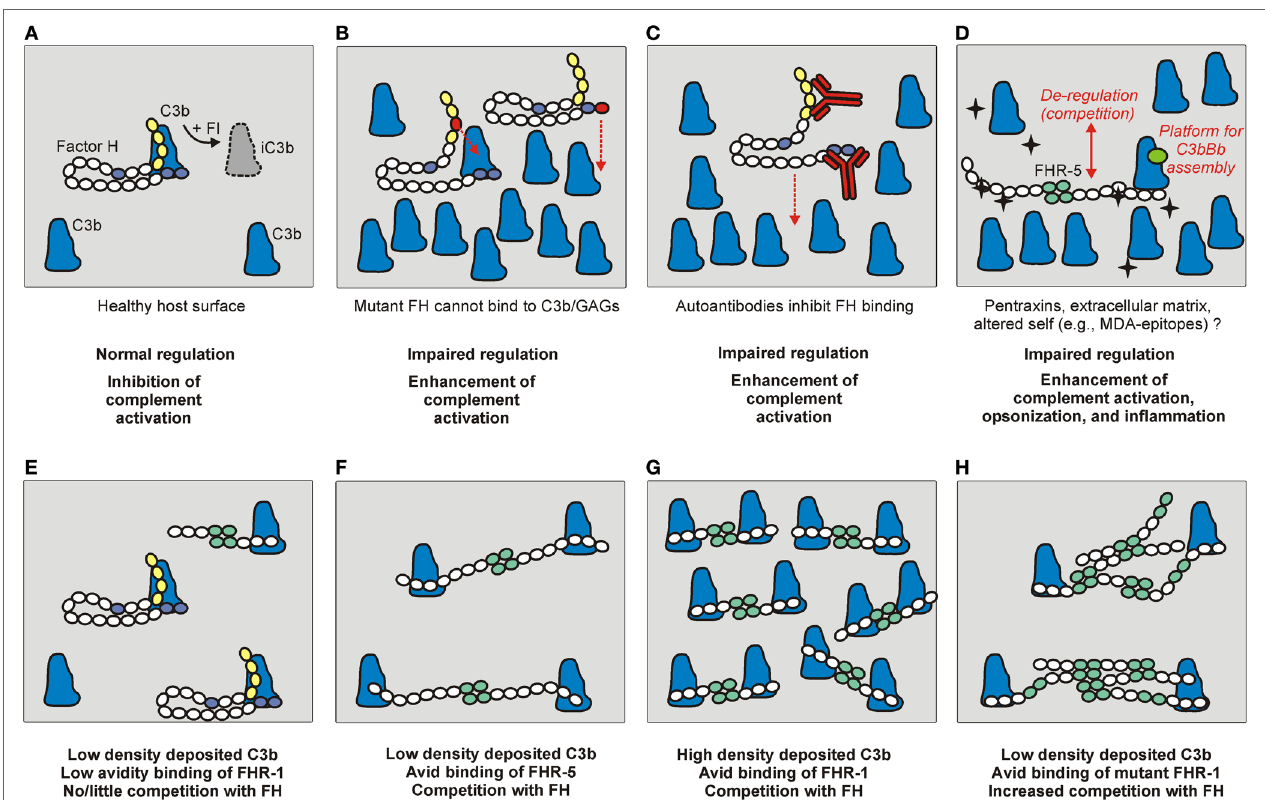
FigURe 3 | The role of factor H (FH) and the FHRs under physiological and pathological conditions. (A) Normal complement control on a healthy host surface by FH bound to surface-deposited C3b. FH recognizes self surfaces under complement attack by binding to a complex of GAGs/sialic acid and C3b. This recognition is mediated by complement control proteins (CCPs) domain 19–20 indicated in blue. Through the activity of the N-terminal regulatory domains (CCPs 1–4, in yellow), FH assists factor I (FI) in the proteolytic cleavage of C3b into inactive C3b (iC3b). (b) Mutations in the regulatory or recognition domains, and (C) autoantibodies bound to these domains can cause functional FH defect and result in impaired surface complement control. (D) FHRs can also interact with similar surfaces and ligands as FH, and compete with FH for binding (de-regulation), and/or they can directly activate the alternative pathway by binding C3b and serving as a platform for the assembly of an active C3bBb convertase. The black star-shape indicates newly exposed ligand/altered self. (e–H) The relative FH/FHR concentrations, the ligand density (avidity), and the dimeric/oligomeric states of the FHRs influence surface complement regulation. (e) At low ligand (e.g., deposited C3b) density and relative FH surplus, FH can potently regulate complement activation on the surface. (F) Increased FHR levels and/or (g) ligand densities, and (H) formation of higher order oligomers (e.g., due to duplicated dimerization domains) can cause enhanced competition with FH and tip the balance to increased complement